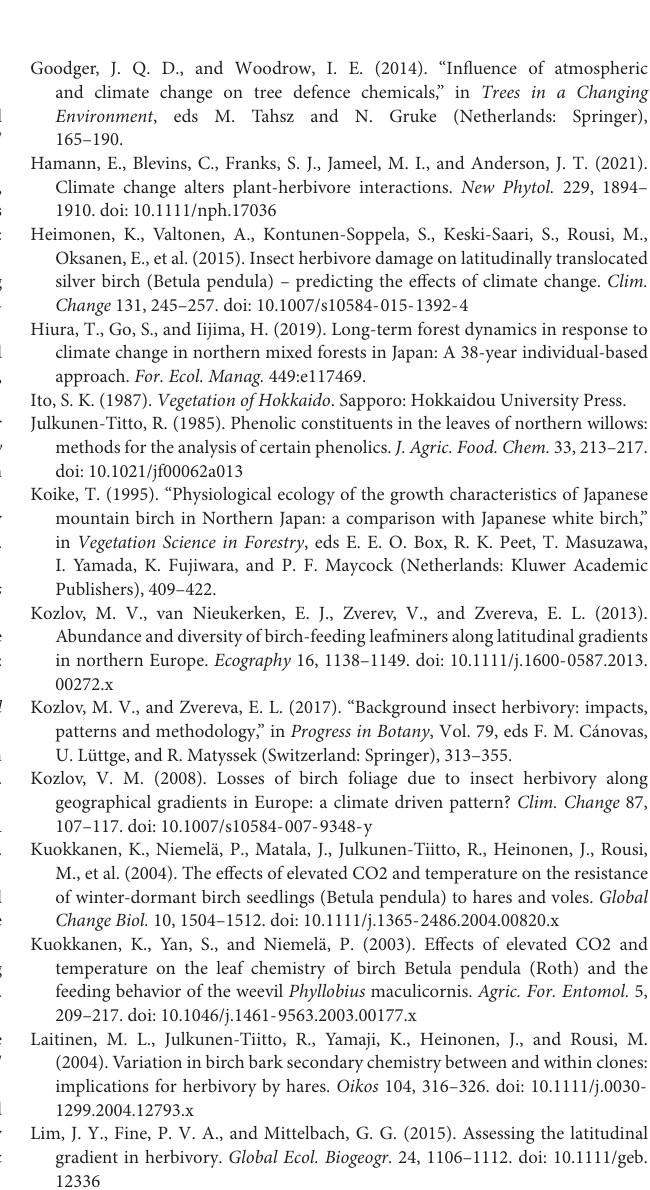
Supplementary Table 2 | Summary of the best-fit models by GLMs explaining the variation in herbivory rate in (A) the elevational-gradient study and (B) the warming